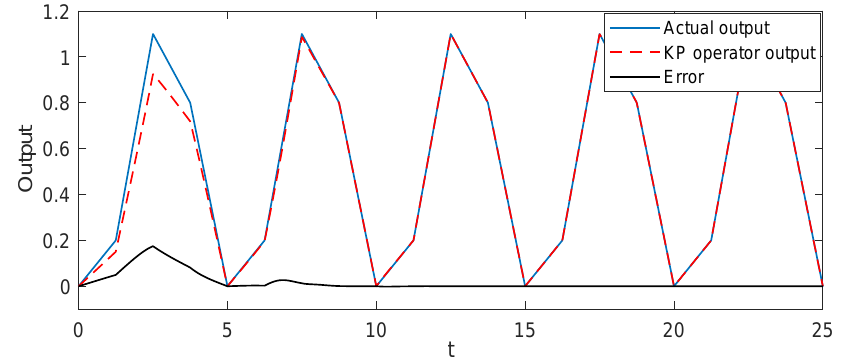
Figure 3. Simulation results of the KP model with the gradient descent algorithm under the triangular wave voltage